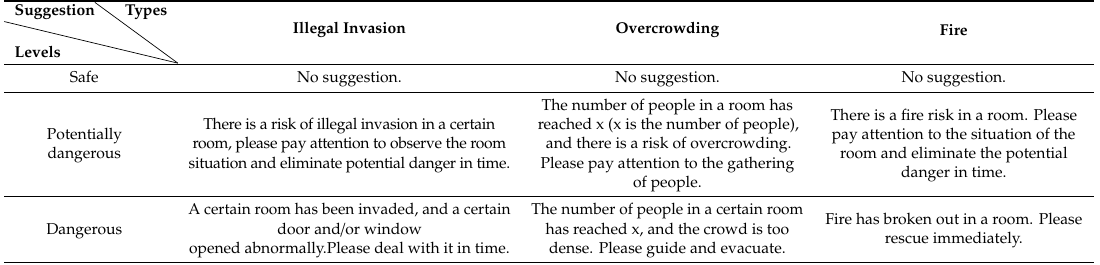
Table 2. Suggestions for handling di ff erent danger types and